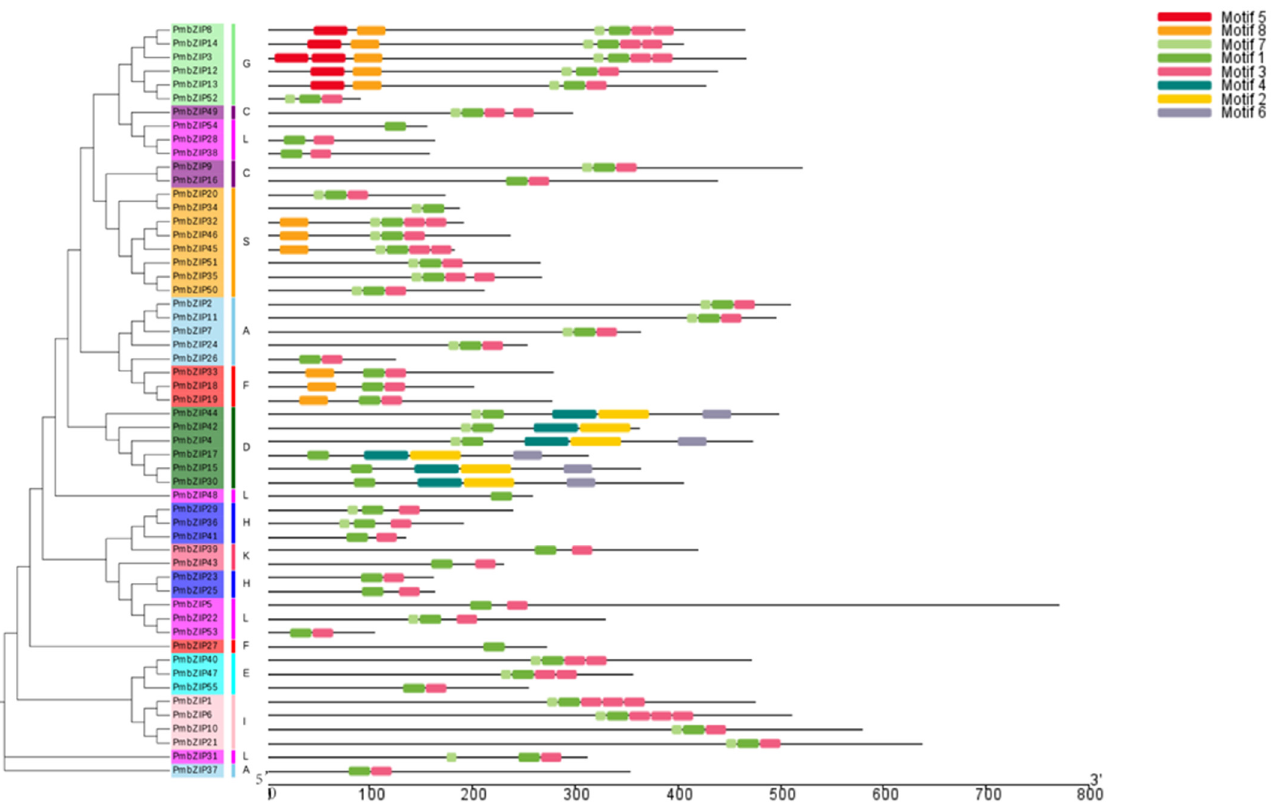
Figure 3. Motif analysis of the bZIP TFs in P. massoniana . The motif structures were obtained by MEME analysis. Eight conserved motifs of PmbZIP proteins are shown, and the different colors represent different kinds of motifs.